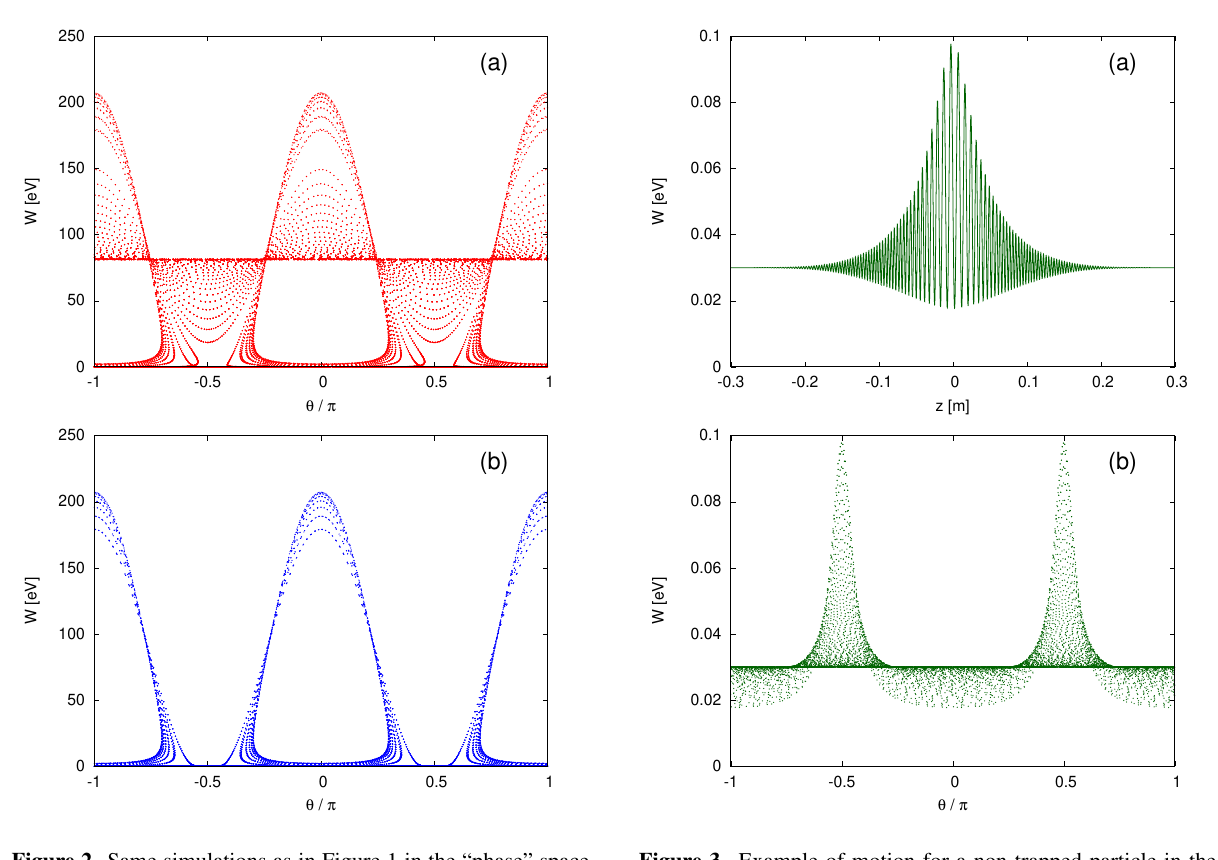
Figure 2. Same simulations as in Figure 1 in the “phase” space ( W ,θ ).